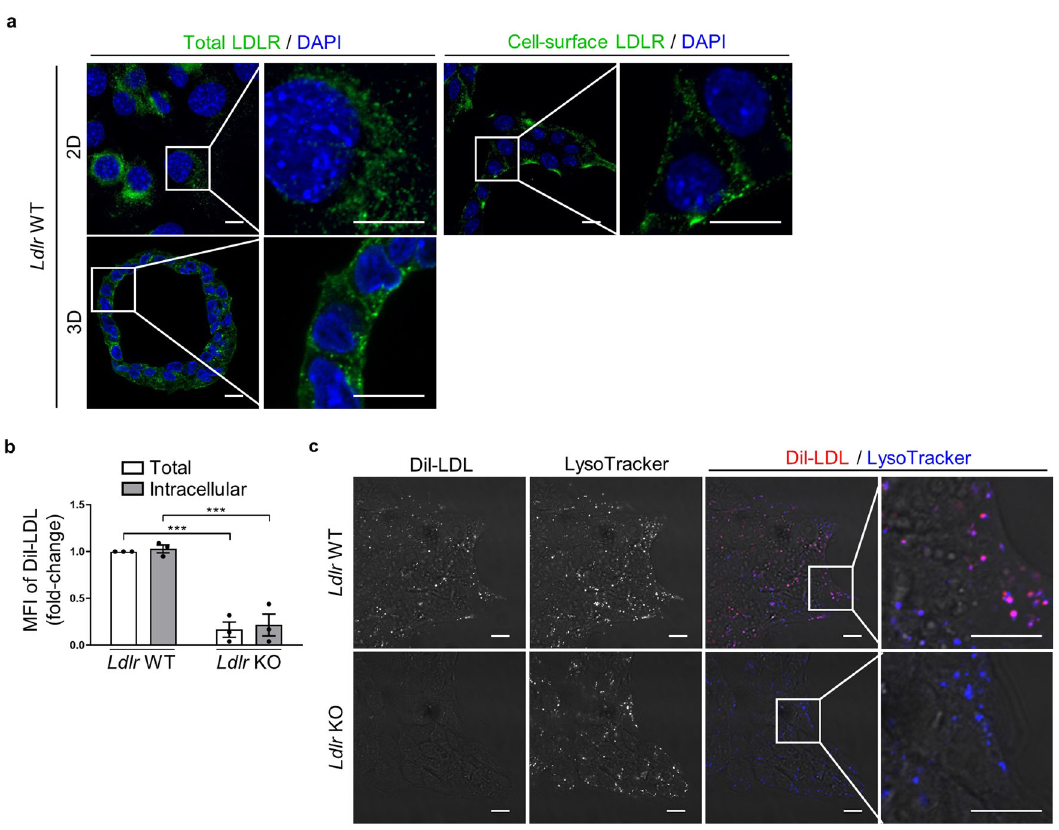
Fig. 2 LDLR-dependent internalization and traf fi cking of LDL toward lysosomal compartment in pancreatic cancer cells. a Representative confocal microscopy images of total and/or cell surface LDLR (in green color) in 2D and 3D Ldlr WT cells. ×60 magni fi cation, scale bar: 10 µ m. An enlarged merge image of indicated part is provided in inset box. n = 2 independent experiments. b Flow cytometry assessment of total DiI-LDL (i.e., bound and internalized) in Ldlr WT and KO PK4A cells and of intracellular DiI-LDL in cells previously treated with an acid solution. Data are represented as fold-change ± s.e.m. of the mean of fl uorescence intensity (MFI) of DiI-LDL and are expressed relative to value obtained in Ldlr WT cells and arbitrarily set to 1. One-way ANOVA with post-hoc Tukey HSD test, *** p < 0.001. n = 3 independent experiments. c Representative confocal microscopy images of DiI-LDL (in red color) and LysoTracker blue (i.e., late acidic endosome and lysosome marker) in live Ldlr WT and KO PK4A cells. x60 magni fi cation, scale bar: 10 µ m. An enlarged merge image of indicated part is provided in inset box. n = 3 independent